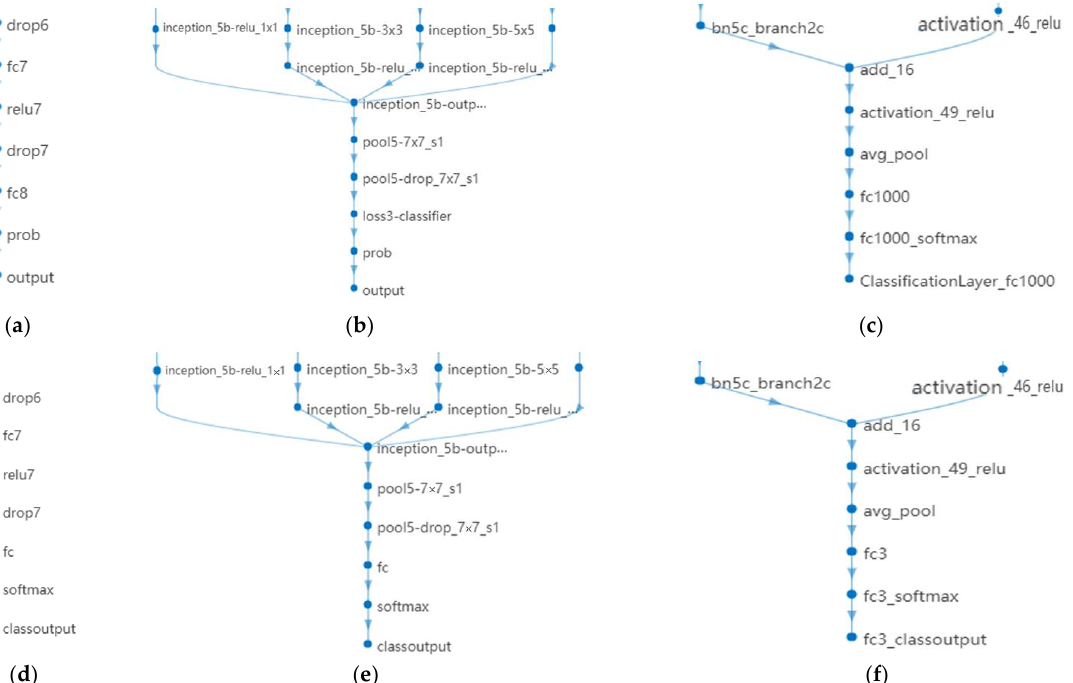
Figure 13. The origin models and the modified models by replacing the last three layers: ( a ) origin AlexNet, ( b ) origin GoogLeNet, ( c ) origin ResNet, ( d ) modified AlexNet, ( e ) modified GoogLeNet, ( f ) modified ResNet.